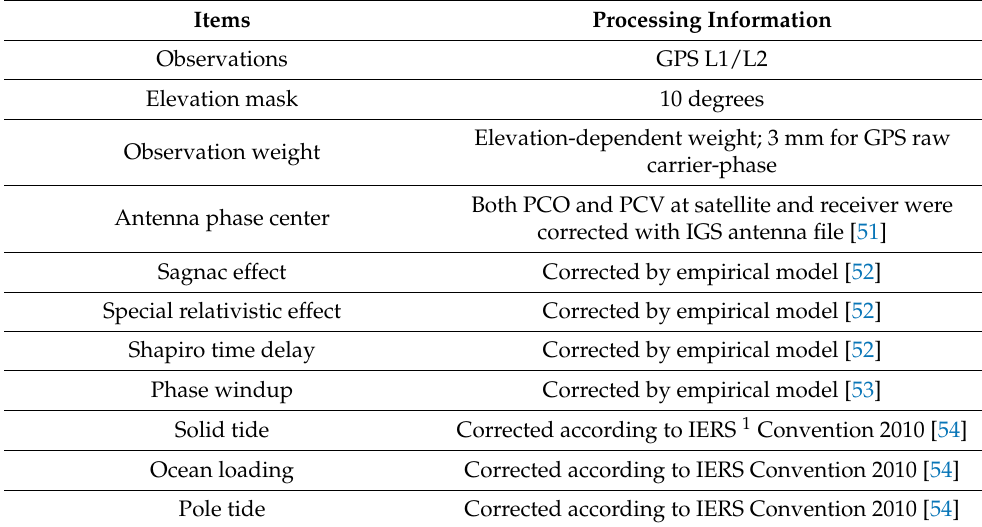
Table 2. Data processing strategies for TPP